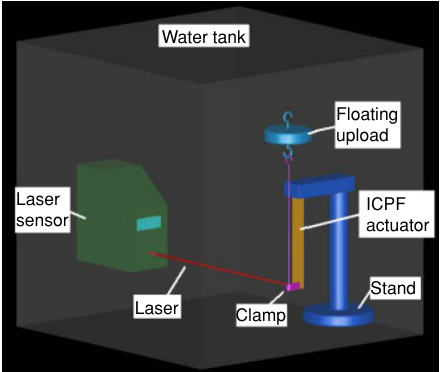
Figure 16 The upload ability measurement system simulating the driver’s state in Walker-1.